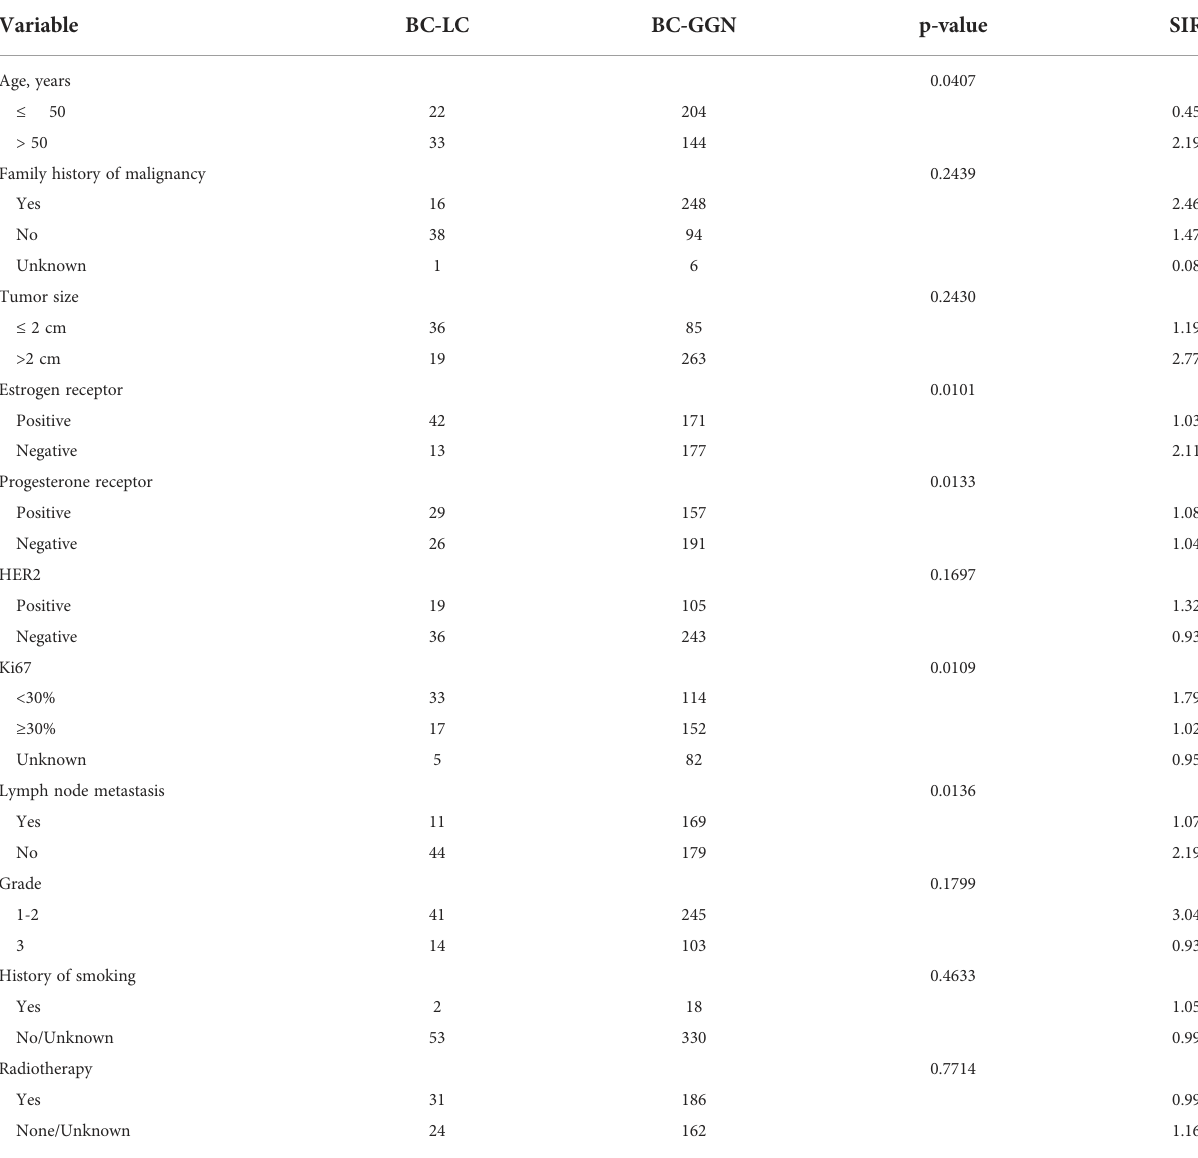
TABLE 1 Clinicopathological characteristics of breast cancer patients.